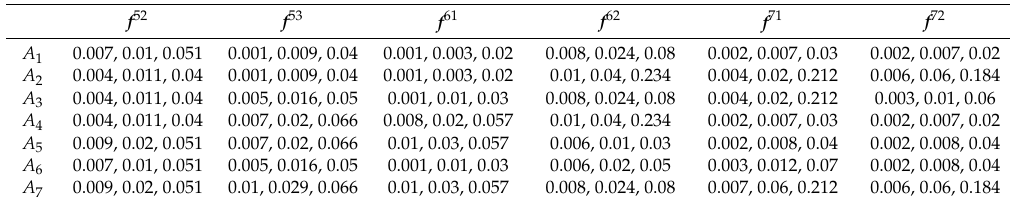
Table 11. Weighted normalized matrix for factor 5, 6 and